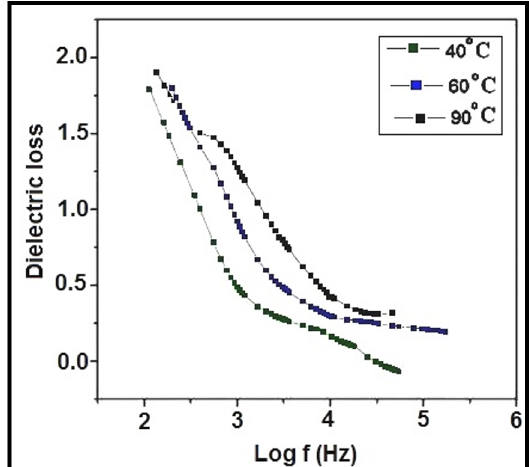
Fig.7. Dielectric loss of TiO